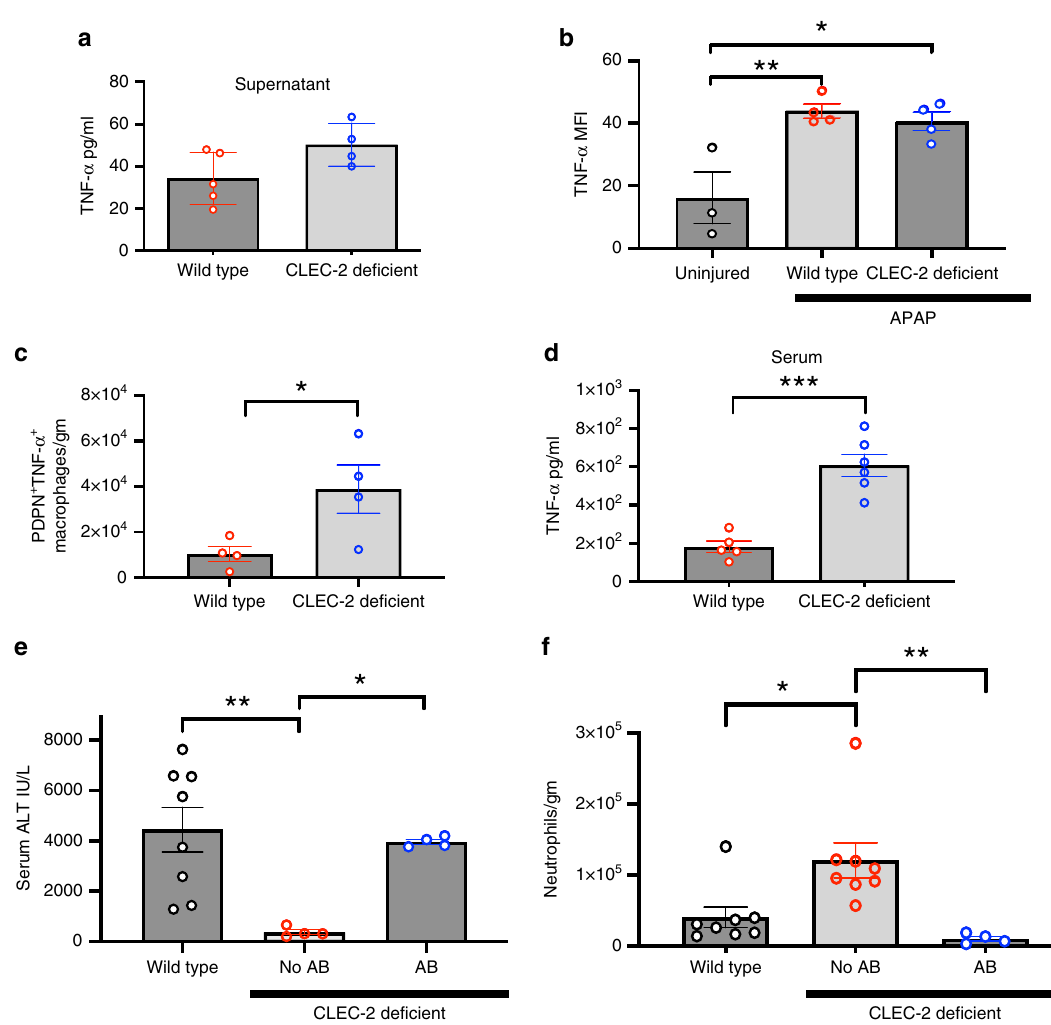
Fig. 5 Macrophage produced TNF- α recruits neutrophils after toxic injury. a TNF- α concentration in supernatant from in vitro LPS stimulated wild type murine macrophages cultured with either WT or CLEC-2 de fi cient platelets (data from six individual mice in each group. b Wild type or CLEC-2 de fi cient (PF4Cre CLEC1b fl / fl mice) were injected with IP APAP (350 mg/kg)] or PBS. Livers were removed at 24 h, digested and then macrophages isolated (de fi ned by the gating strategy CD45 + CD3 − CD11b + F4/80 + ) and then using fl ow cytometric analysis TNF-(mean fl uorescent intensity (MFI) was calculated